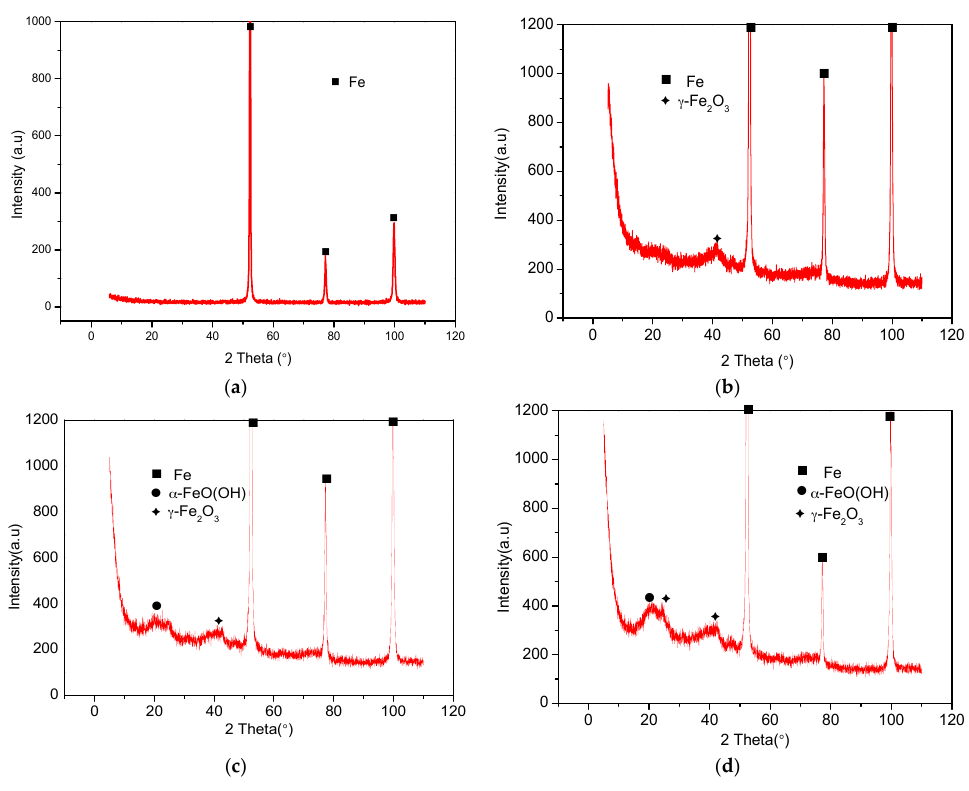
Figure 10. XRD analysis of corrosion product after corrosion test of mild steel in bicarbonate/chloride solution at 2000 rpm: ( a ) un-immersed ( b ) un-inhibited ( c ) 1 g/L NO 2 − ( d ) 1 g/L NO 2 − + 1 g/L KI.